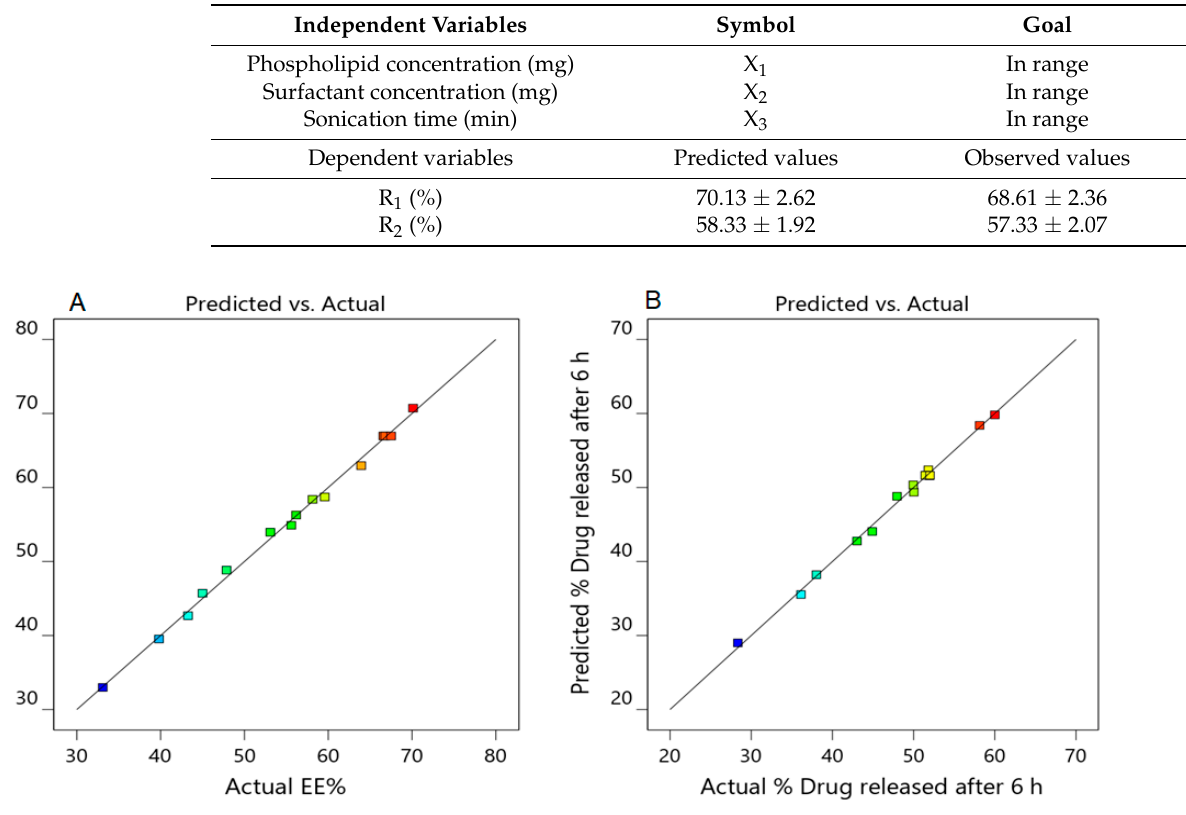
Figure 3. Linear correlation plots between actual and predicted values for all dependent variables; ( A ) for Y 1 ; ( B ) for Y 2 . Table 4. Results of statistical analysis of all dependent variables Y 1 and Y 2